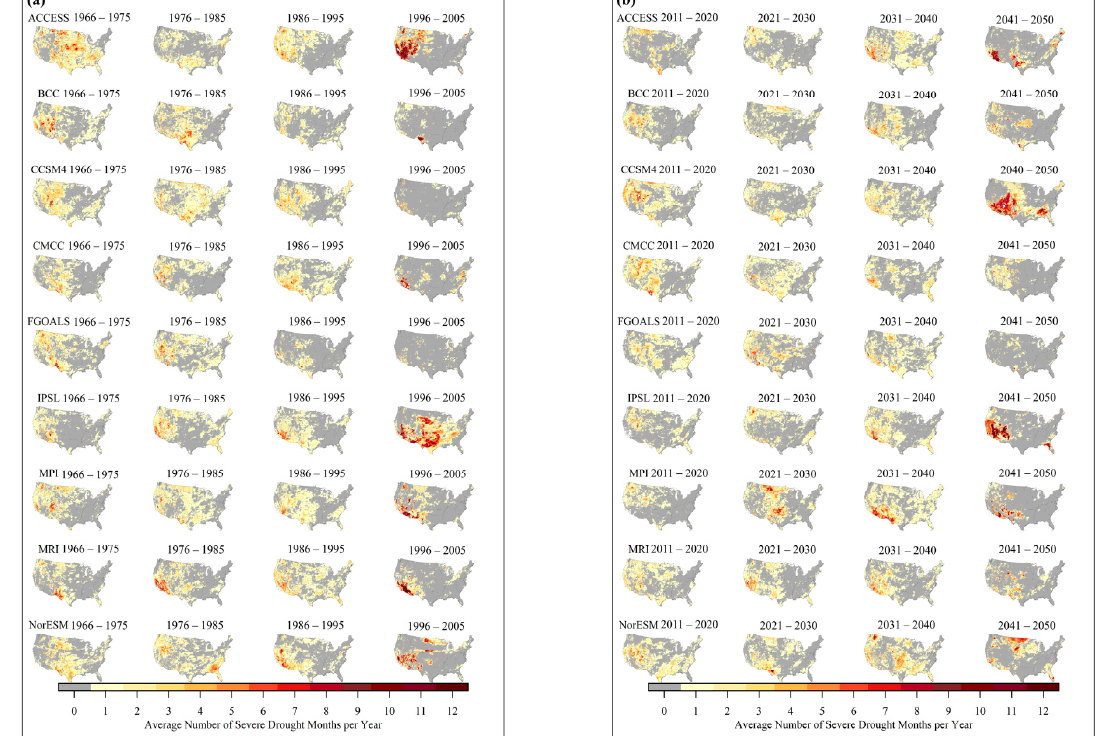
Figure 5. The spatial occurrence of severe droughts in decadal time periods for the historical ( a ) and projected ( b ) periods. Each map in the figure shows the average number of severe drought months per year for the indicated decade.